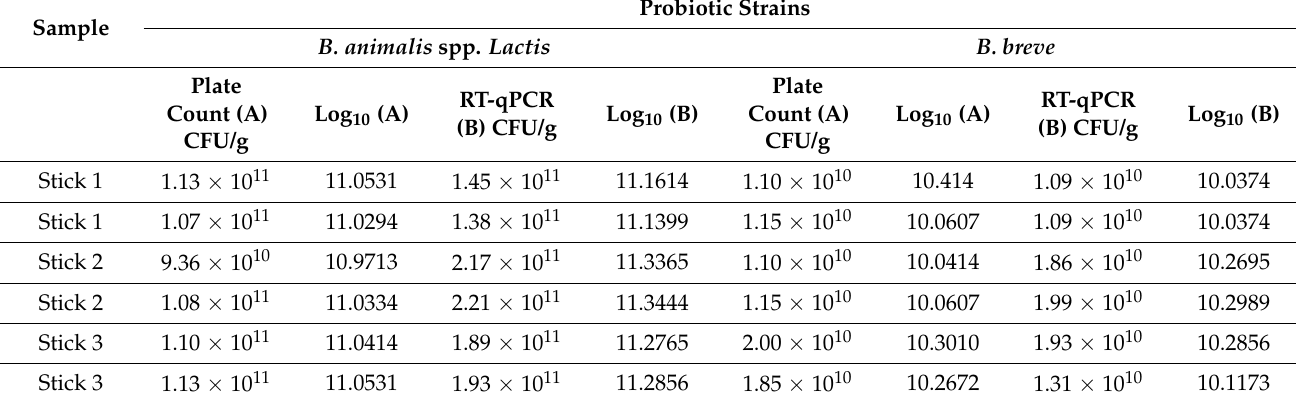
Table 7. Count results by RT-qPCR of food supplement 2 expressed as Log10 for Bifidobacterium animalis spp. lactis, and Bifidobacterium breve .